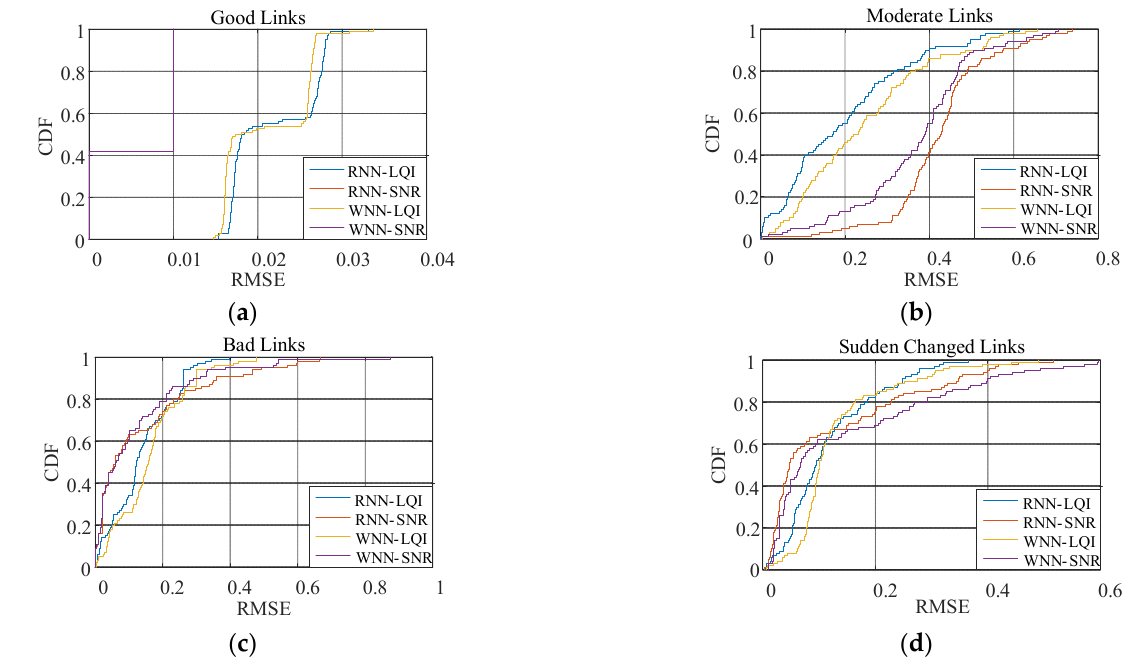
Figure 11. CDF of the RMSE for PRR prediction under different link qualities. ( a ) good links, ( b ) moderate links, ( c ) bad links, ( d ) sudden changed links.